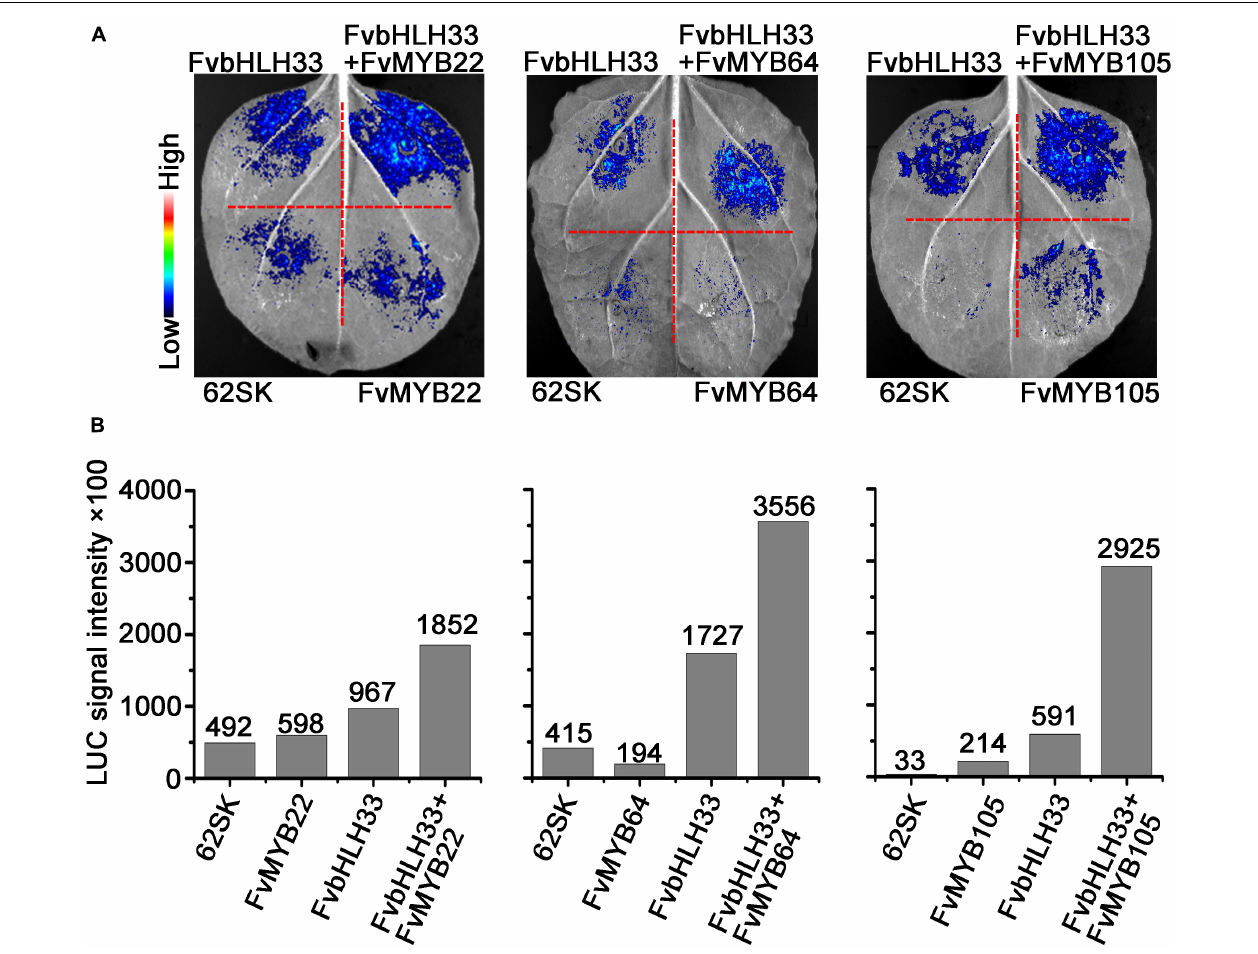
FIGURE 8 | The effect of interactions between MYB and bHLH proteins on the DFR2 promoter fused with luciferase reporter gene. The constructs encoding the indicated combinations of proteins were co-transformed into tobacco leaf epidermal cells, and the luminescence images were captured using a CCD imaging system (A) , the intensity of luminescence was indicated in (B)